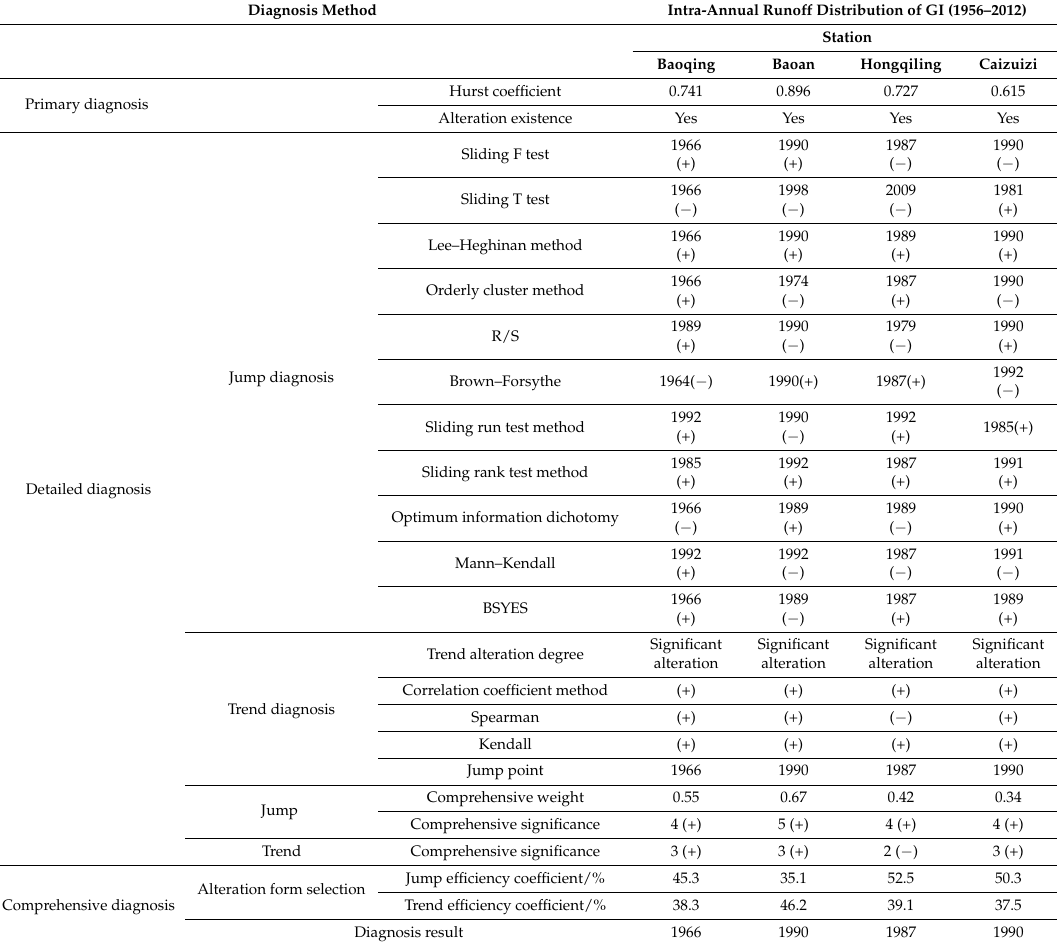
Table 1. Results of the hydrological variation diagnosis